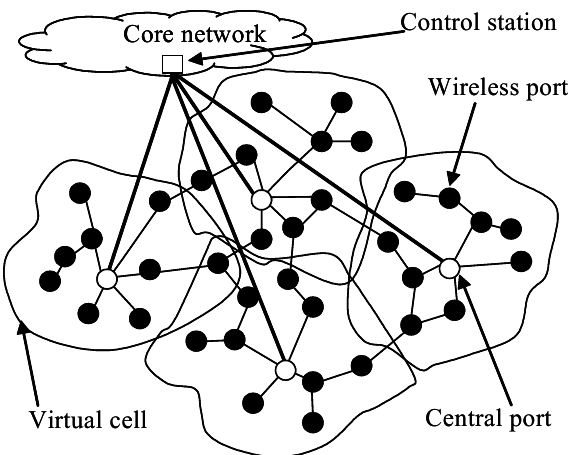
Figure 8. A simplified 5G linking channel [40].